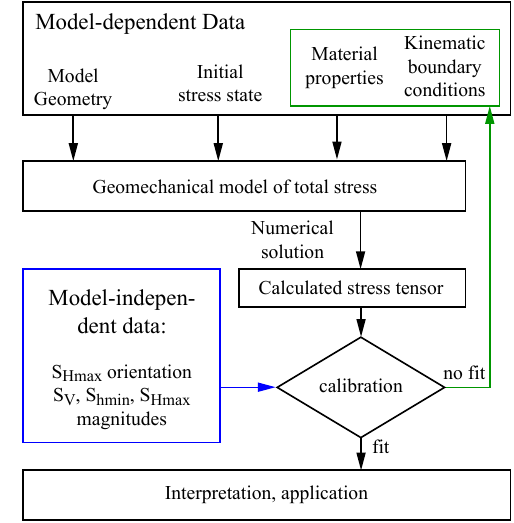
Figure 1. Sketch of the general workflow. The geomechanical model is prepared based on the model geometry, the material prop- erties, the variable displacement boundary conditions and the ini- tial stress state. The numerically modelled total stress tensor is cal- ibrated on model-independent in situ stress data until the model fits the calibration